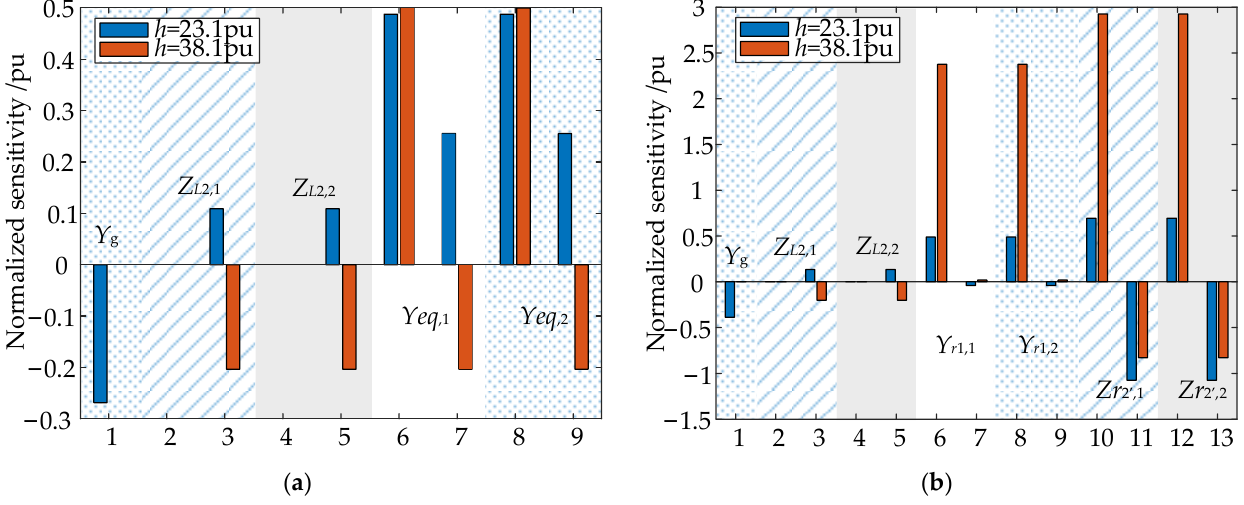
Figure 14. The results of the sensitivity analysis comparison are: ( a ) the sensitivity without the de- composed conductance model; ( b ) the sensitivity using the decomposed conductance model.